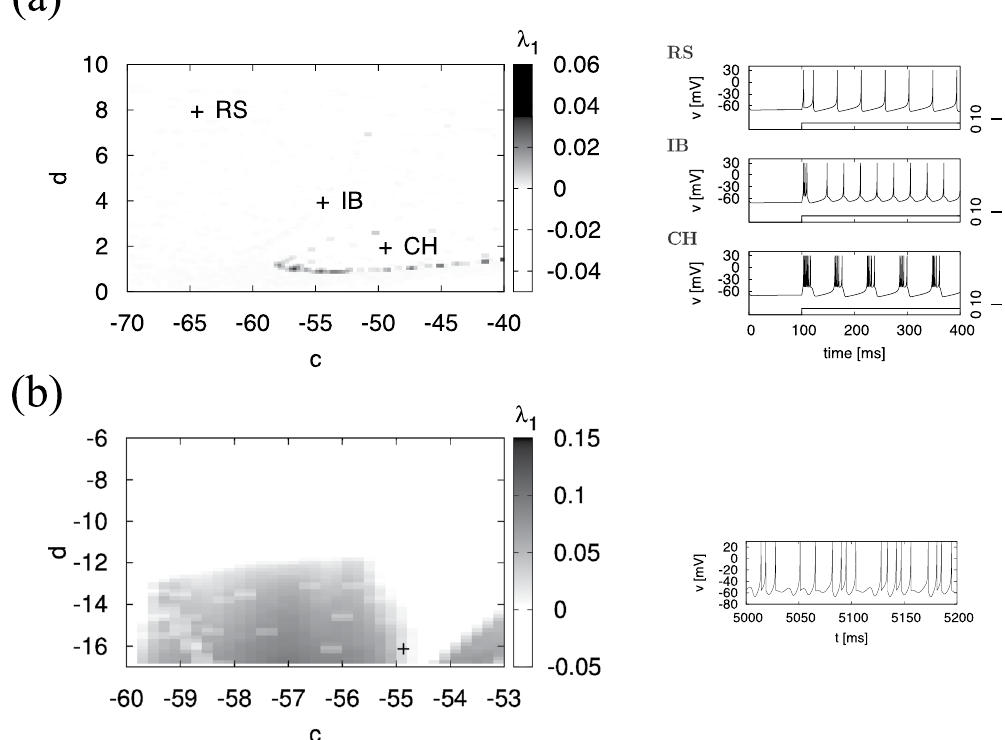
Figure 1. Dependence of maximum Lyapunov exponent λ 1 on parameters c and d . ( a ) Region around the parameter sets for regular spiking (RS), intrinsically bursting (IB), and chattering (CH). The symbols of ( + ) indicate the parameter sets for RS and IB, CH ( a = 0.02, b = 0.2, I = 10). The chaotic states ( λ 1 > 0) exist in − 59 ≲ c ≲ − 40, d ≈ 1.0. ( b ) Region around the parameter set proposed by Izhikevich for chaotic spiking. The symbols of ( + ) indicate the parameter set for chaotic spiking ( a = 0.2, b = 2, I = − 99). The chaotic states ( λ 1 > 0) exist in d ≲ −